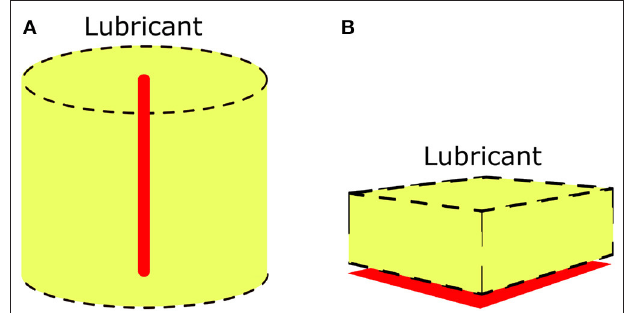
FIGURE 4 | Measurement of lubricant thermal properties with (A) transient hot-wire method and (B) laser flash method. The yellow color indicates lubricant, and the red is the heat